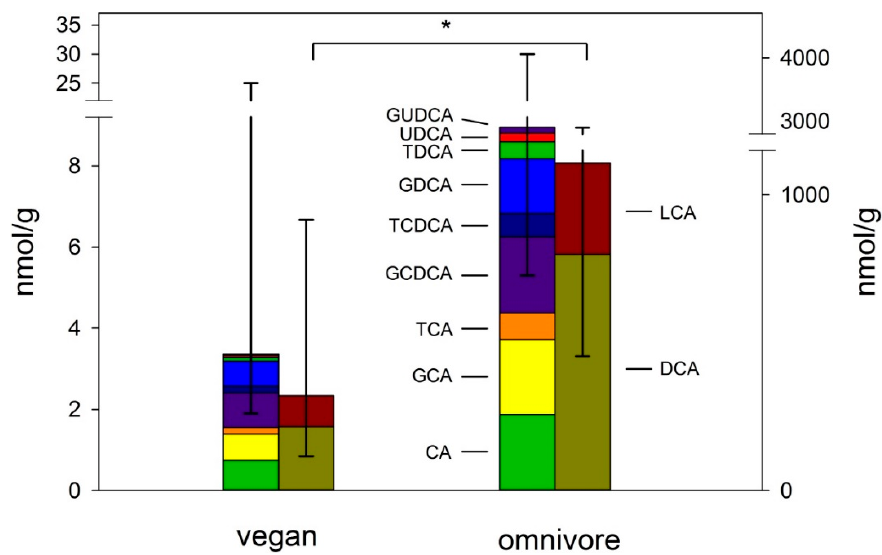
Figure 1. Fecal bile acid concentrations in vegans and omnivores of the Risk and Benefits of a Vegan Diet study (RBVD) study (nmol/g). Data are presented as medians and interquartile range (IQR) for total fecal bile acids. Mann–Whitney U test was used for bile acids (* p ≤ 0.001). Values for secondary bile acids are presented on right y -axis, while primary and conjugated bile acids are presented on left y-axis. CA= Cholic acid, GCA = glycine-conjugated CA, TCA = taurine-conjugated CA, GCDCA = glycine-conjugated Chenodeoxycholic acid, TCDCA = taurine-conjugated CDCA, DCA = Deoxycholic acid, GDCA = glycine-conjugated DCA, TDCA = taurine-conjugated DCA, UDCA = Ursodeoxycholic acid, GUDCA = glycine-conjugated UDCA, LCA = Lithocholic acid, DCA = Deoxycholic acid.